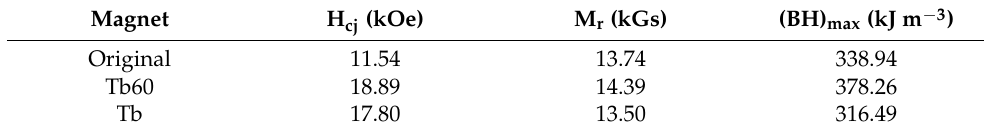
Figure 1. Demagnetization curves of the original and the Tb60 and Tb diffusion magnets. Table 1. The magnetic properties of the original and the Tb60 and Tb diffusion magnets.